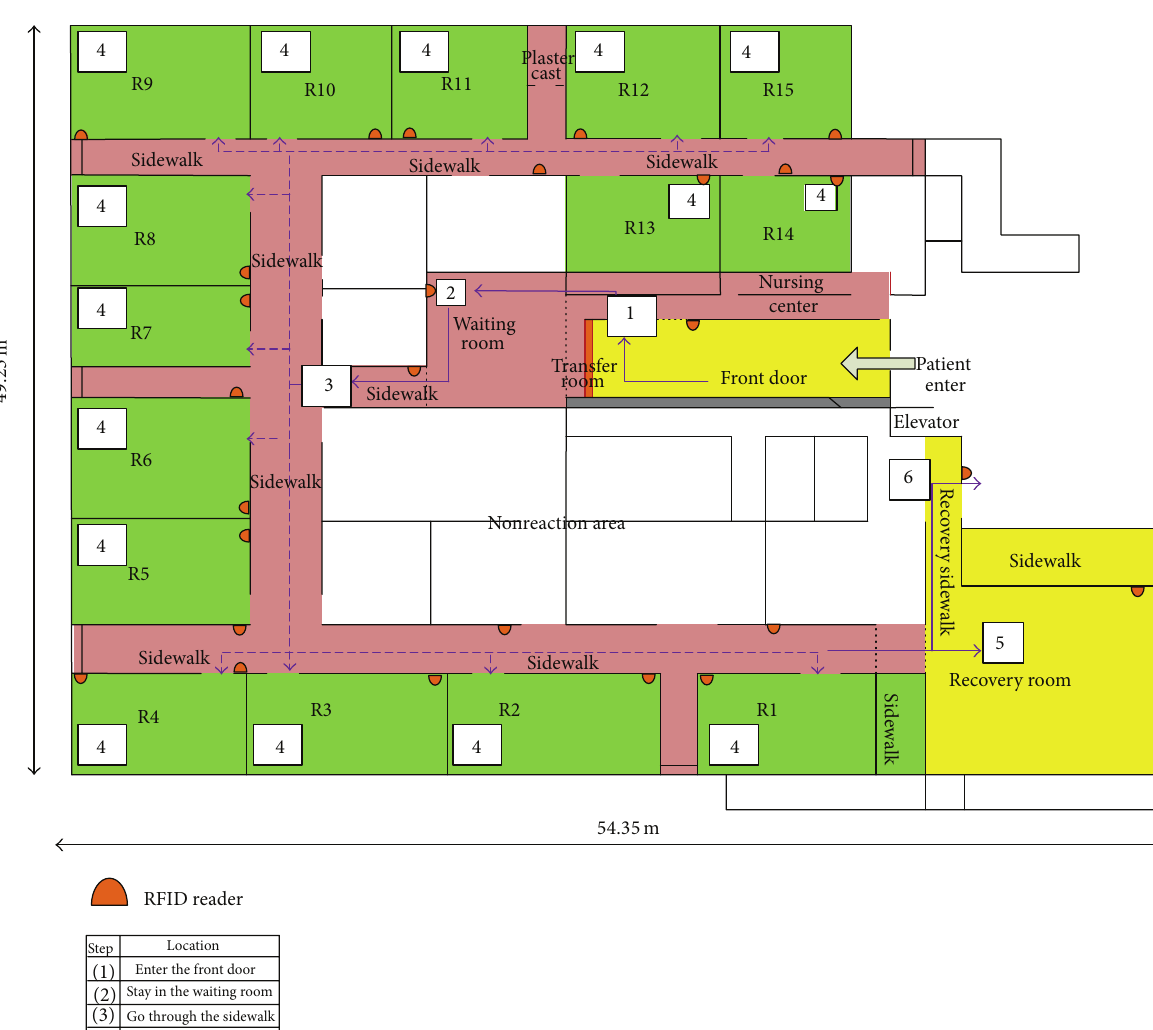
Figure 4: The layout of the surgery room of a teaching hospital located in Taipei,